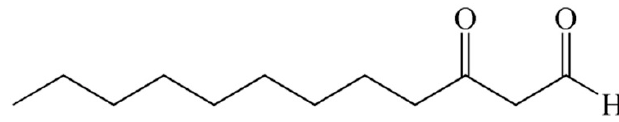
Figure 1. Chemical structure of Hou ( 3-oxododecanal) .